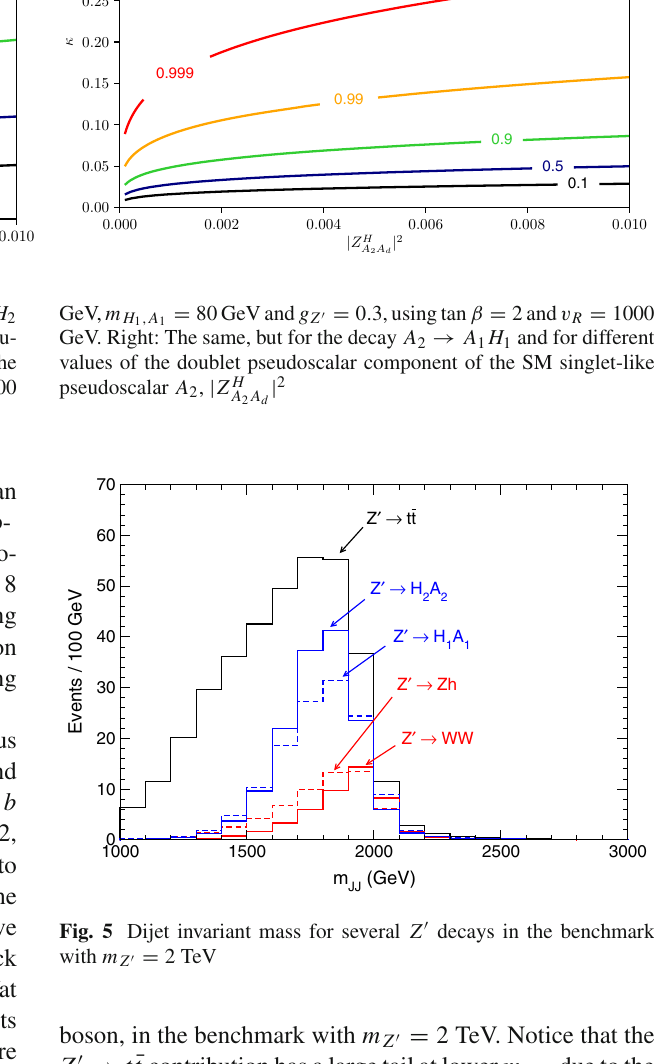
Fig. 5 Dijet invariant mass for several Z (cid:2) decays in the benchmark with m Z (cid:2) = 2 TeV boson, in the benchmark with m Z (cid:2) = 2 TeV. Notice that the Z (cid:2) → t ¯ t contribution has a large tail at lower m J J , due to the semileptonic top decays that are included in our